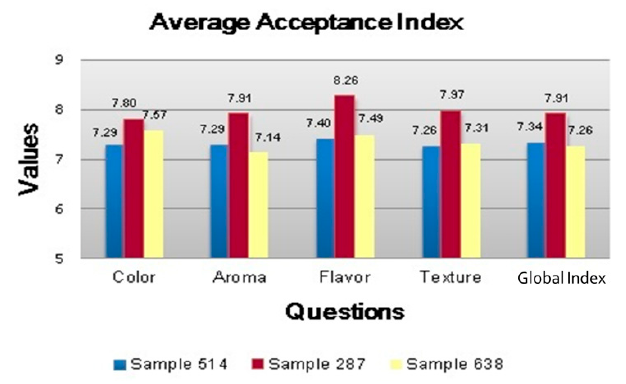
Figure 2. Average Acceptance